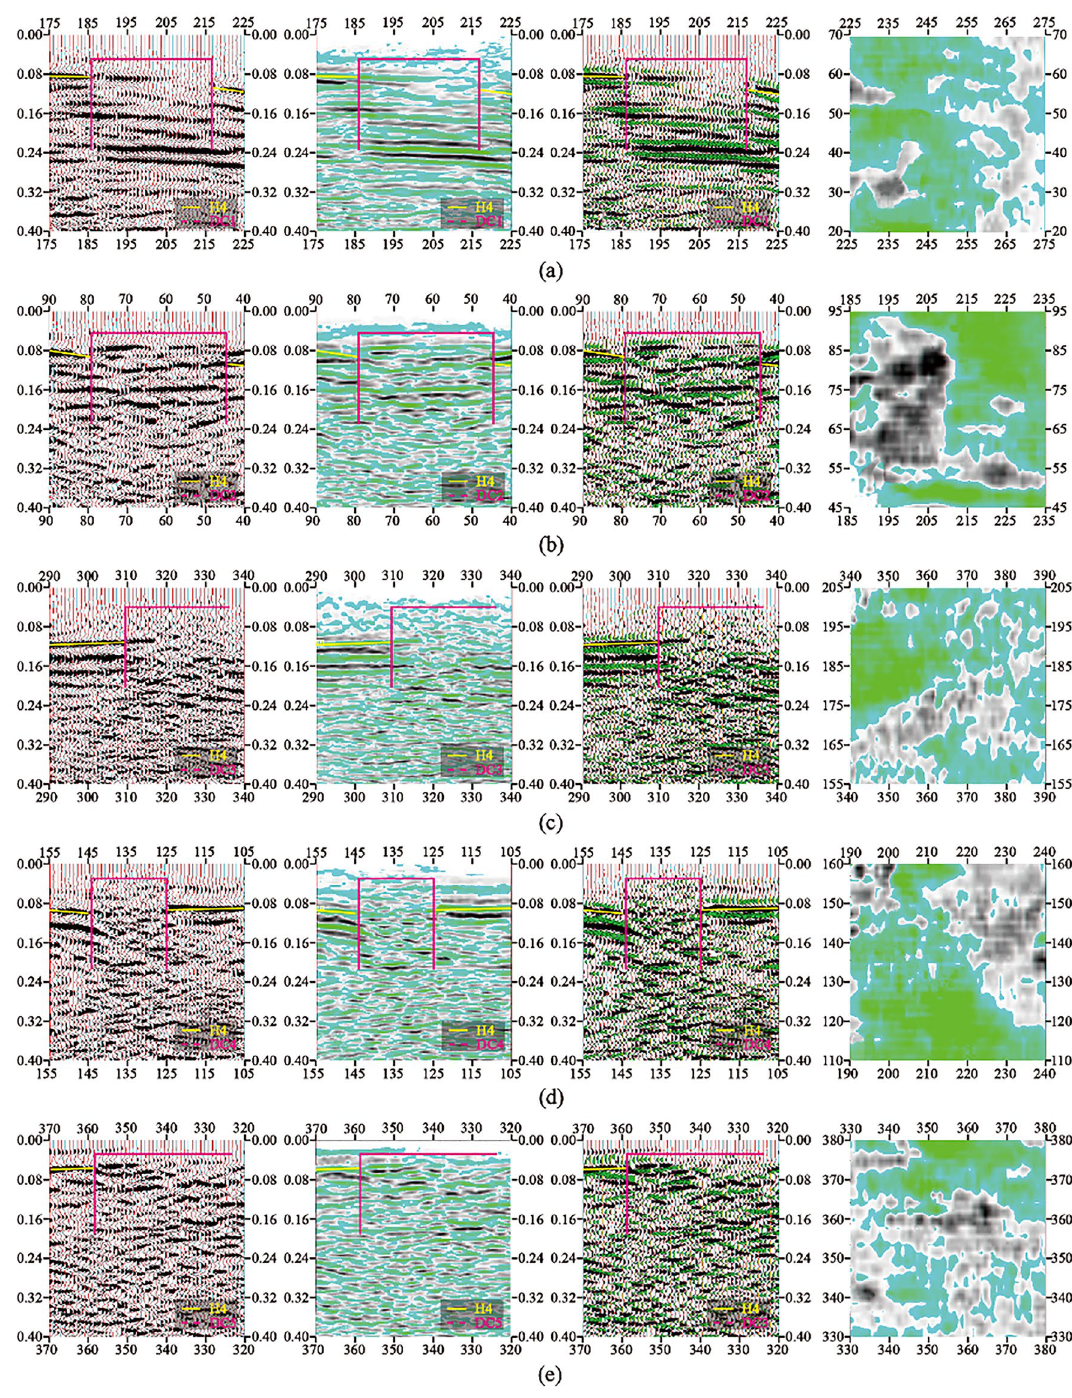
Figure 6. Schematic diagram of interpretation of inferred goaf (3D seismic exploration analysis and detection equipment): ( a ) DCI comprehensive interpretation schematic diagram; ( b ) DC2 comprehensive interpretation schematic diagram; ( c ) DC3 comprehensive interpretation schematic diagram; ( d ) DC4 comprehensive interpretation schematic diagram; ( e ) DC5 comprehensive interpretation schematic diagram; ( f ) DC6 comprehensive interpretation schematic diagram; ( g ) DC7 comprehensive interpretation schematic diagram; ( h ) DC8 comprehensive interpretation schematic diagram; ( i ) DC9 comprehensive interpretation schematic diagram. inferred mined-out areas are clearly reflected in abnormal seismic time